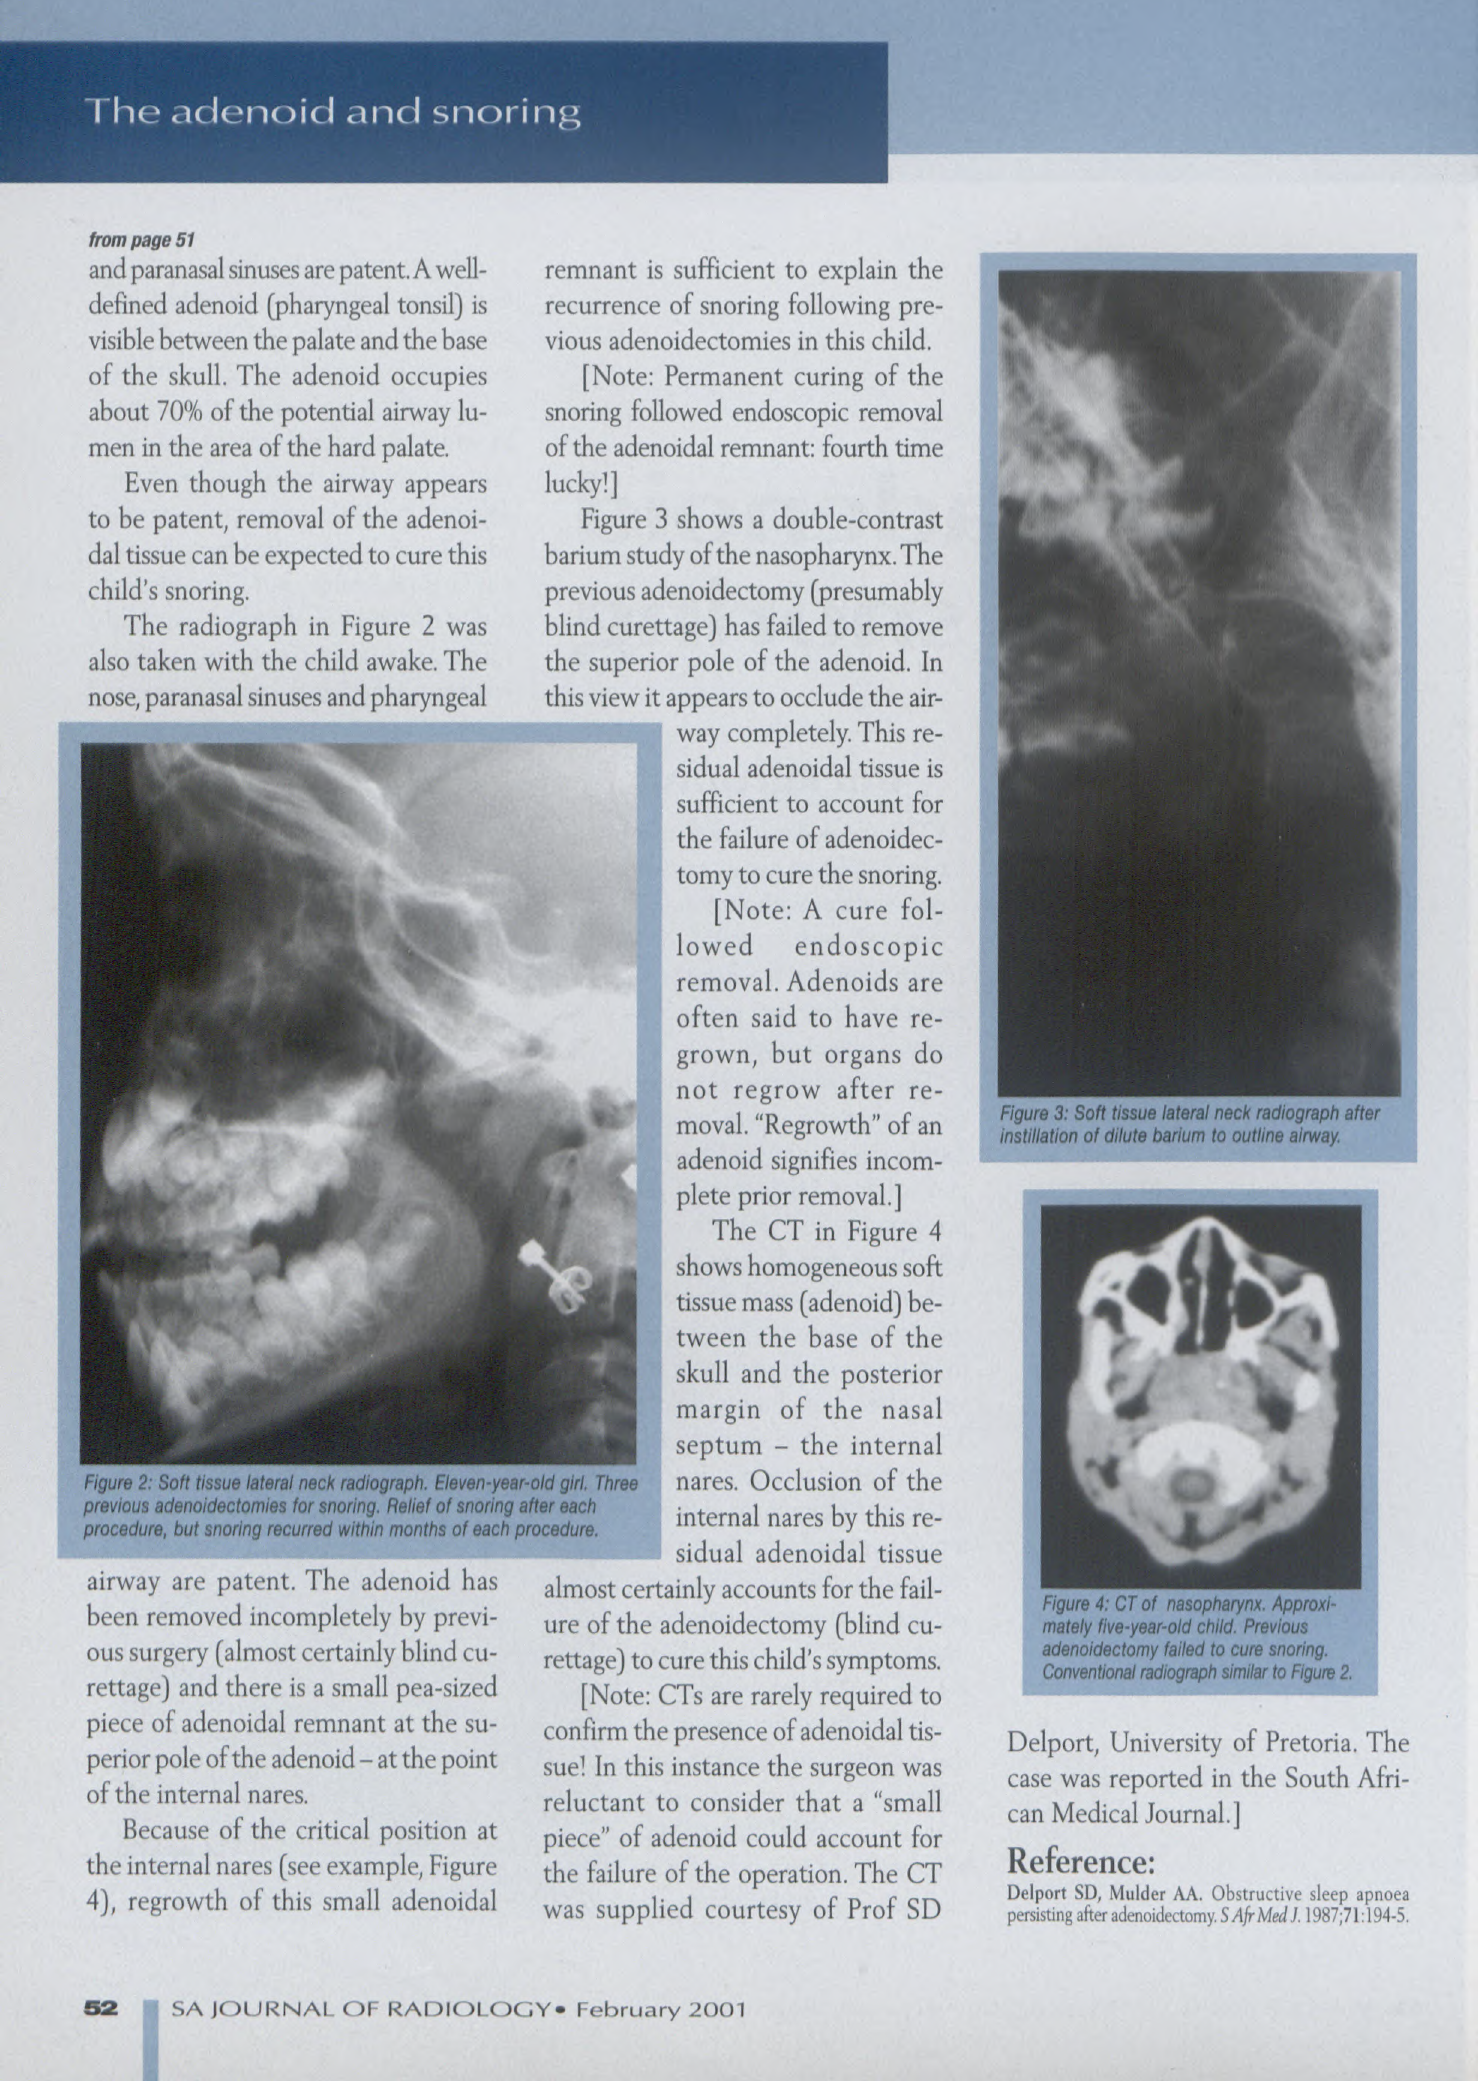
Figure 4: CT of nasopharynx. Approxi- mately five-year-old chi/d. Previous adenoidectomy failed to cure snoring. Conventional radiograph similar to Figure